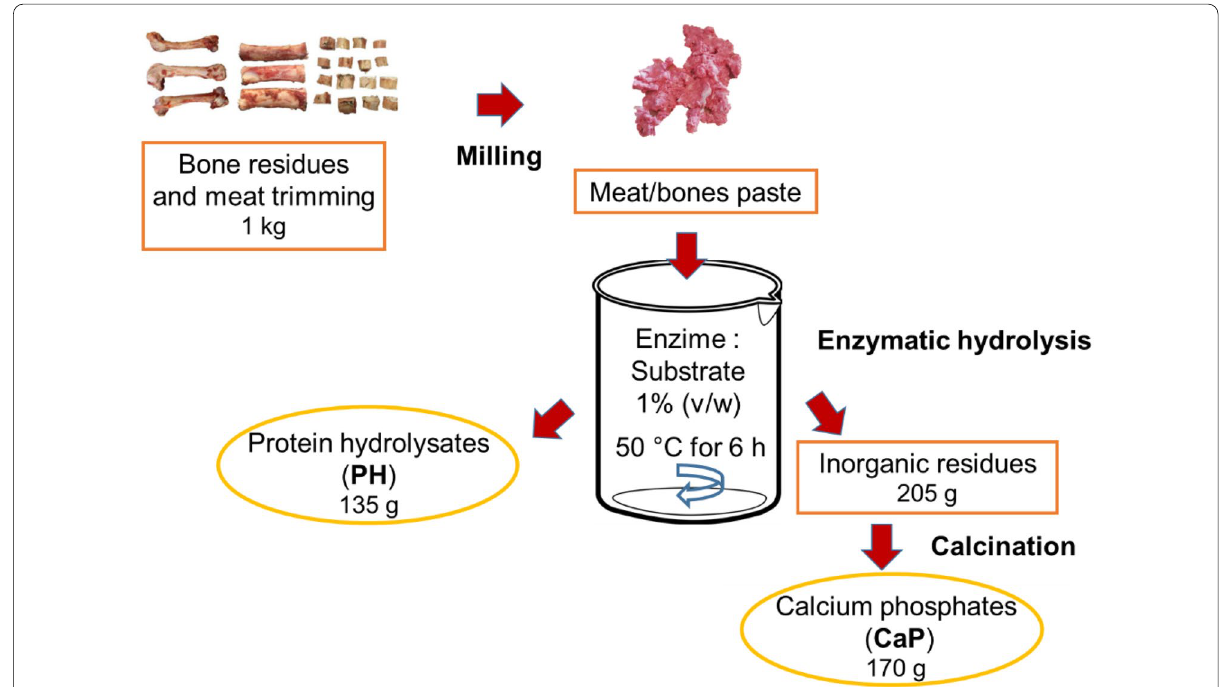
Fig. 1 Scheme of the combined process to extract proteins and